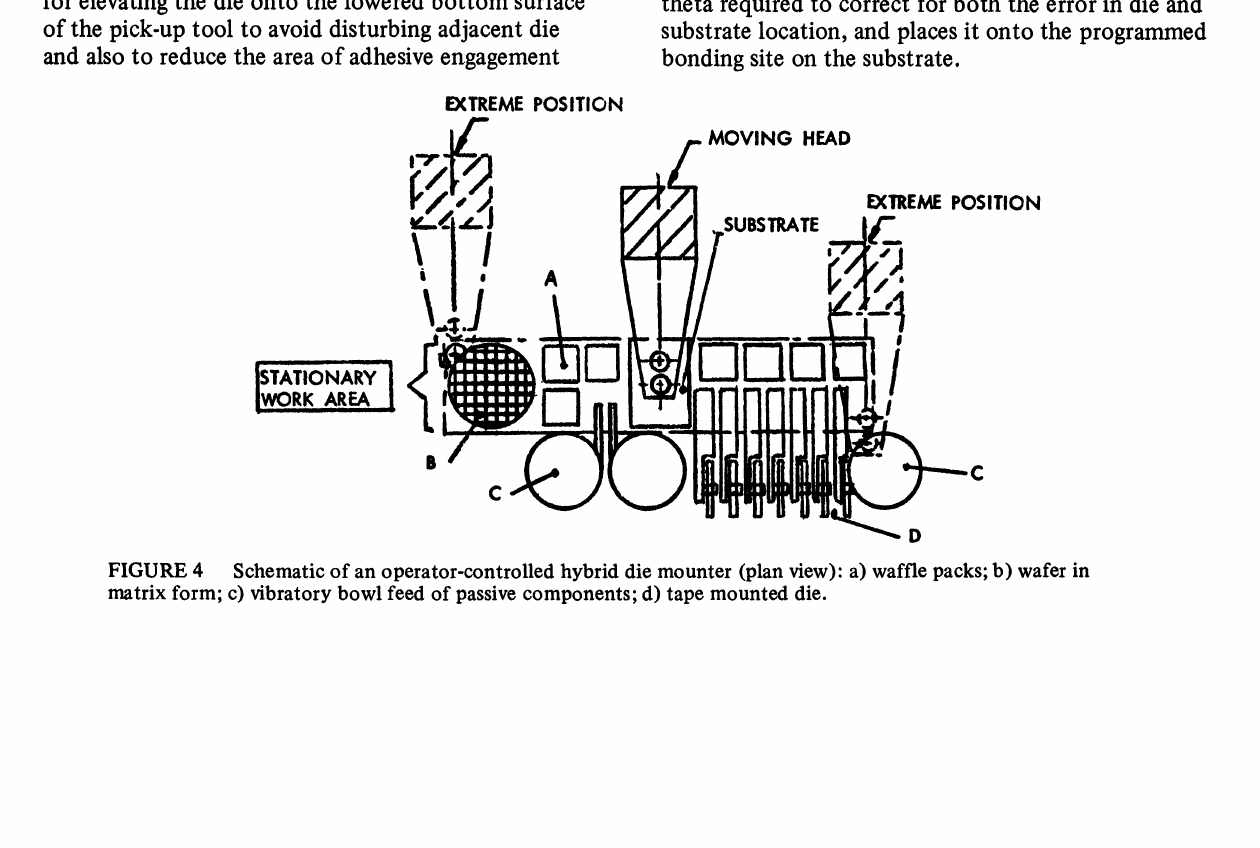
Schematic of an operator-controlled hybrid die mounter (plan view): a) waffle packs; b) wafer in matrix form; c) vibratory bowl feed of passive components; d) tape mounted